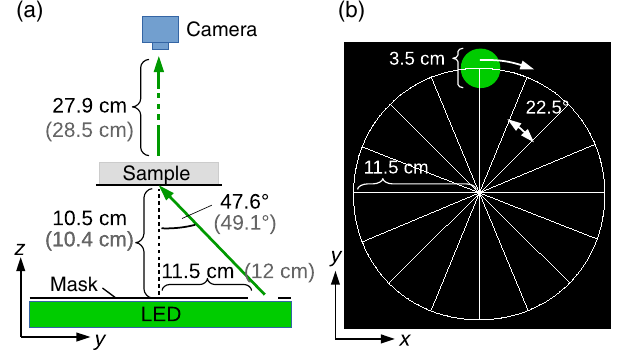
FIG. 10. Schematic setup of the scattering measurement. (a) Side view of the setup, consisting of an LED panel with a mask, a specimen stage with a sample, and a camera. The numbers without brackets belong to the scattering measurement of the vervet brain section (Sec. IV C), and the numbers in brackets to the measure- ment of the human optic chiasm (Sec. IV B). (b) Top view of the mask used for the scattering measurement in Sec. IV C (circular hole with 3.5 cm diameter and 11.5 cm distance from the center, yielding an illumination angle of 47 . 6 ° with respect to the center of the sample). During the measurement, the mask is rotated in steps of 22 . 5 ° around the center in the clockwise direction. [For the scattering measurement in Sec. IV B, a mask with a rectangular hole ( 2 . 4 × 4 cm 2 ) and steps of 15° are used.].